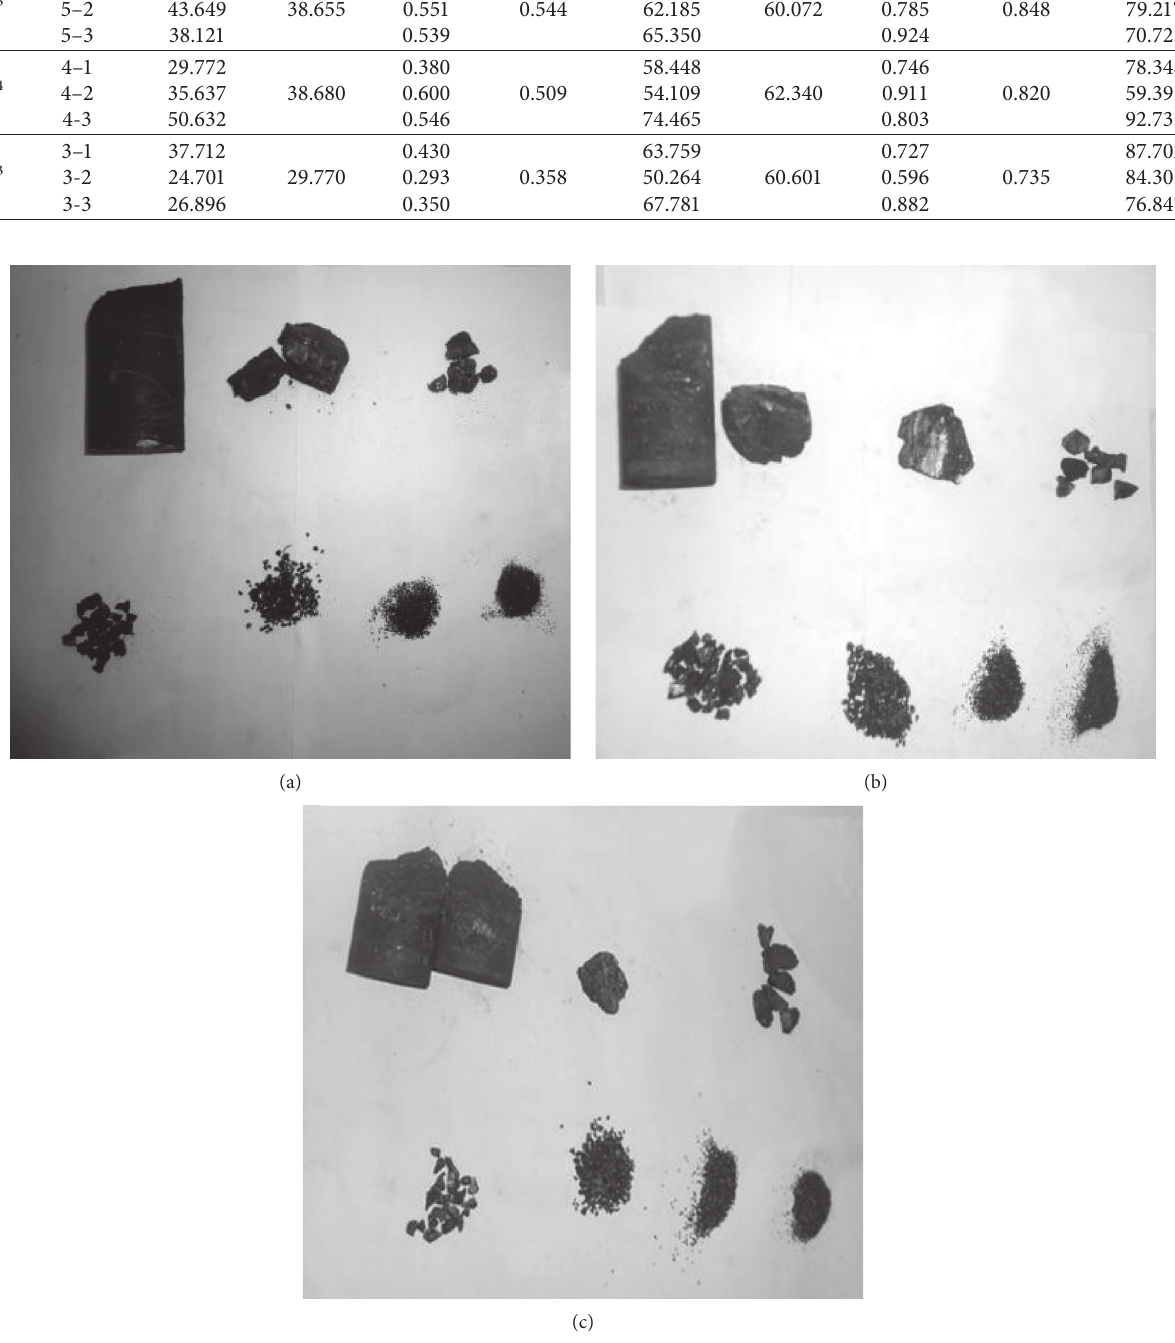
Figure 8: Failure patterns of coal rock under different strain rates. (a) _ ε � 10 − 5 s − 1 . (b) _ ε � 10 − 4 s − 1 . (c) _ ε � 10 − 3 s − 1